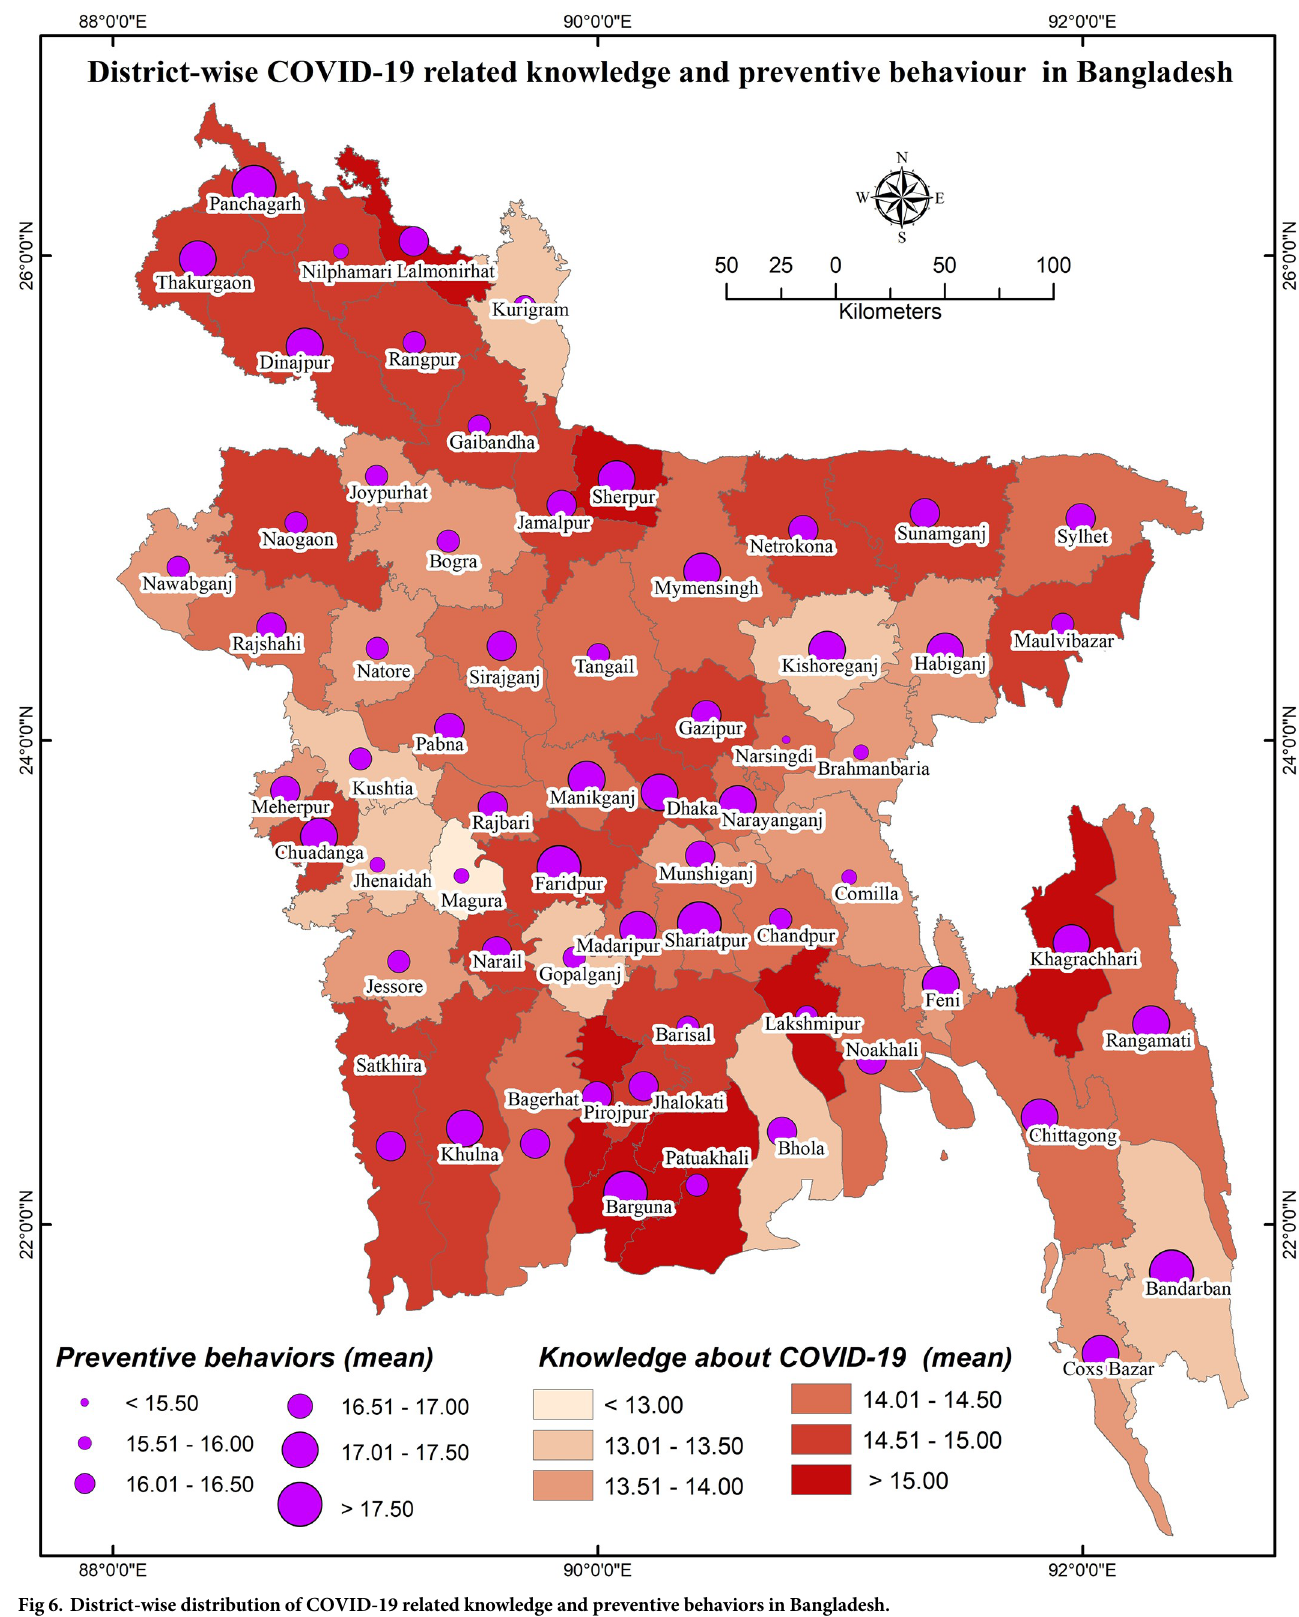
Fig 6. District-wise distribution of COVID-19 related knowledge and preventive behaviors in Bangladesh. https://doi.org/10.1371/journal.pone.0251151.g006 PLOS ONE | https://doi.org/10.1371/journal.pone.0251151 May 3,